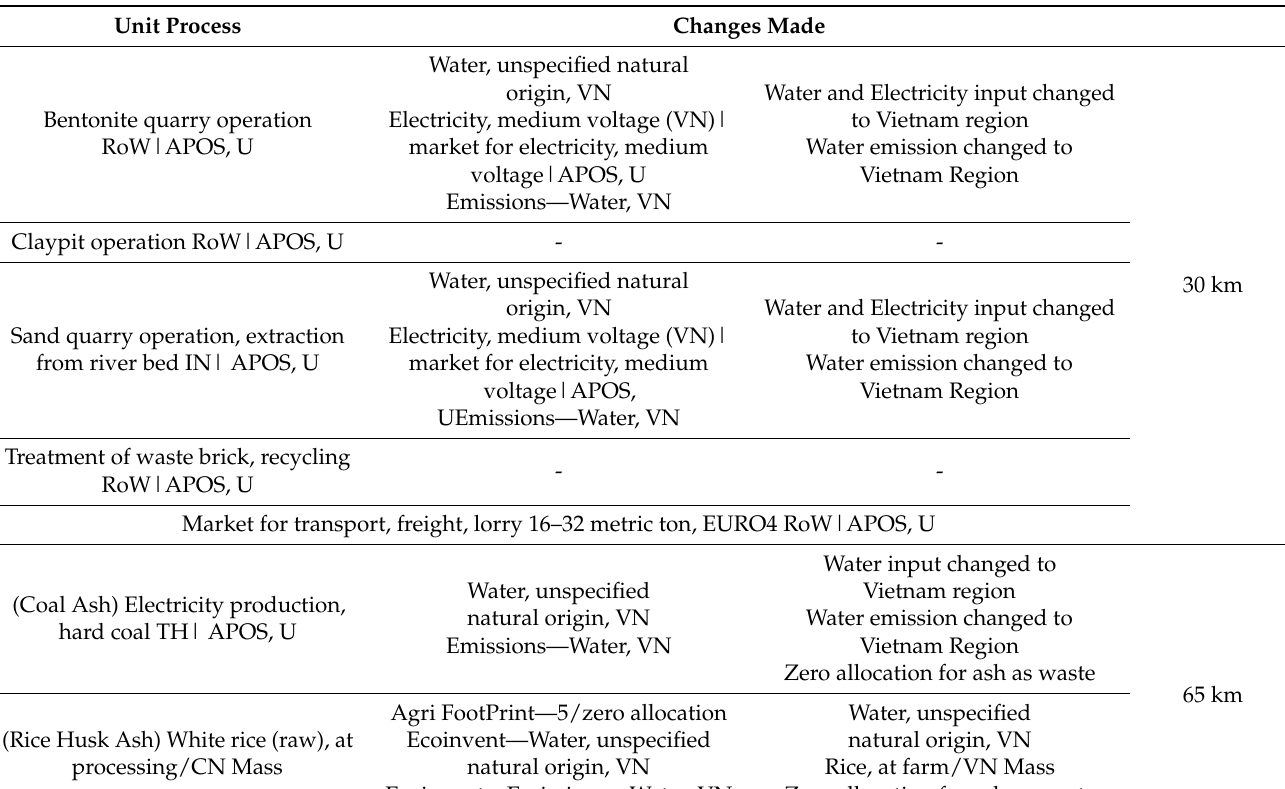
Table 6. Unit Processes used for LCA from Ecoinvent.